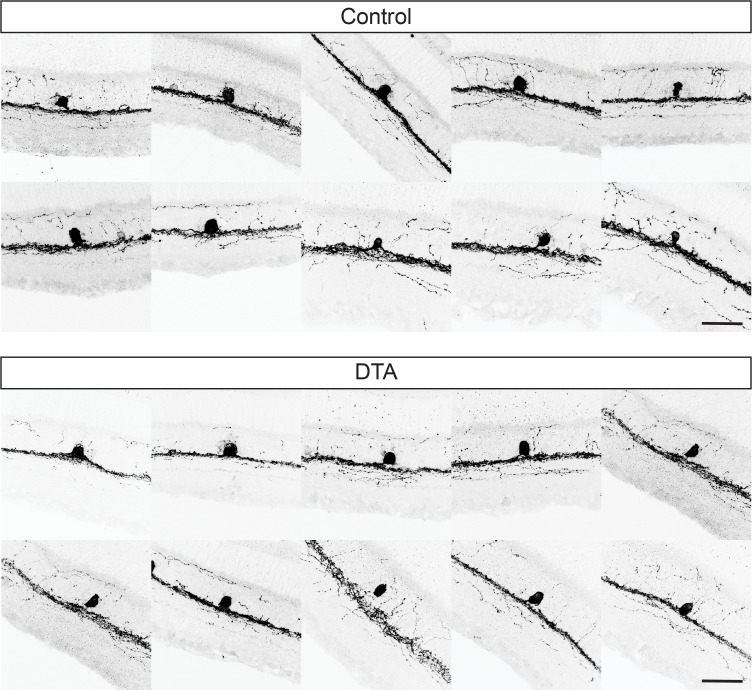
Examples of TH-positive cell stratification in WT and DTA retinas.TH+ cell stratification in WT (top panels) and DTA (bottom panels) retinas show no differences in morphology. Scale bar is 50 μm.